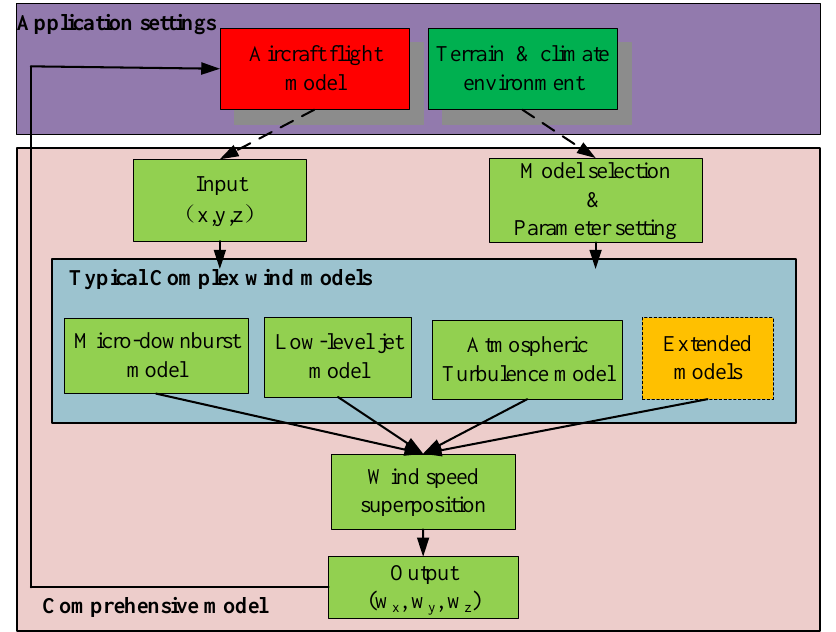
Figure 9. Application structure of the comprehensive wind field model.